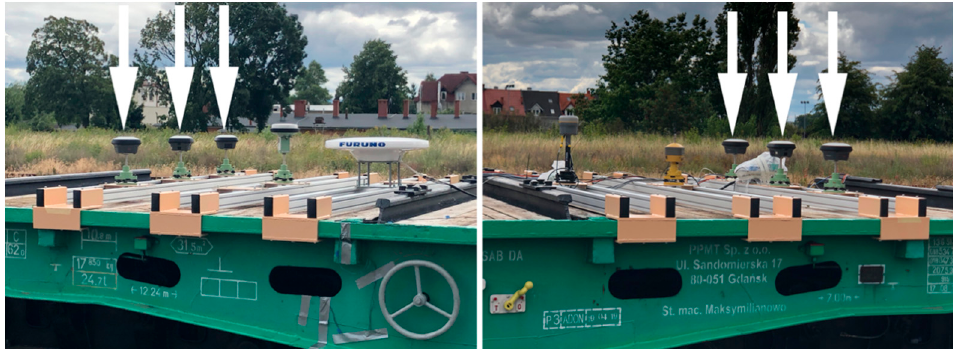
Figure 3. Global Navigation Satellite System (GNSS) receivers by Leica mounted on the mobile surveying platform.